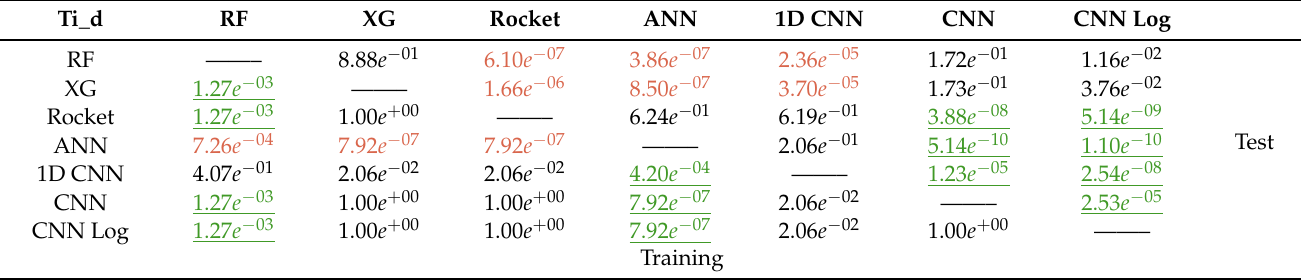
Table A11. Kruskal–Wallis p -values comparing all methods of the Ti_d concentration prediction task. Above the diagonal, we have the results for the test set, and below for the training set. Significant results ( p < 0.01) are represented in green or red when the method on the left is significantly better or worse,